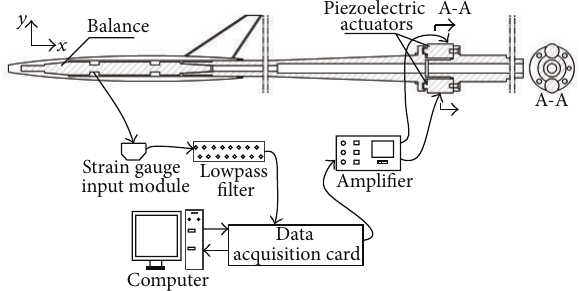
Figure16:Diagramofthewindtunnelevaluationexperimentsetup.